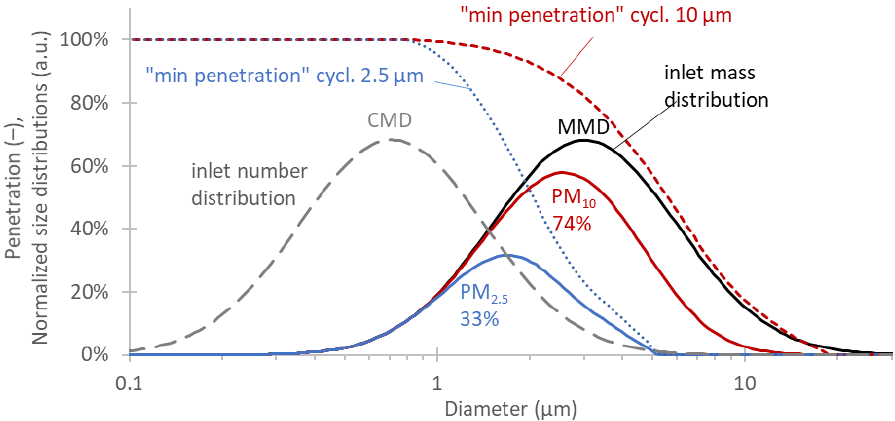
Figure 4. Example of an inlet si ze distribution with count median diameter (CMD) 0.7 µm and geometric standard deviation of 2. This corresponds to mass median diameter (MMD) 3.0 µm. Based on the penetrations of Figure 3a (“min penetration”), the PM 2.5 and PM 10 fractions are 33% and 74%, respectively. The PM 2.5 to PM 10 mass ratio is 45%. “a.u.” = arbitrary units.